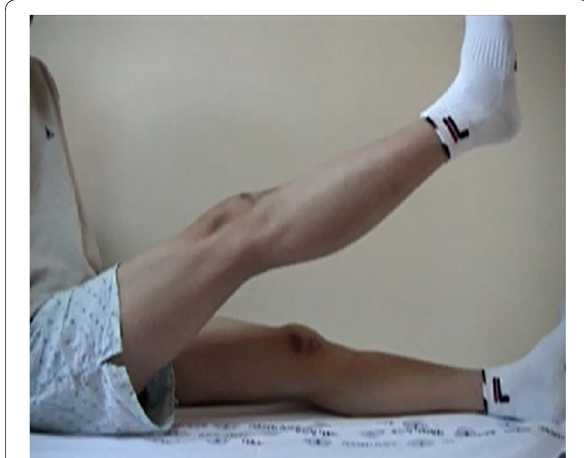
Fig. 5. A photograph of the patient with active straight leg raise, three months following